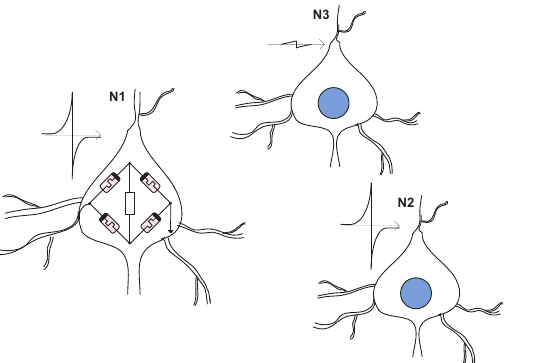
Fig. 9 : Three neurons, N 1 and N 2 are activated, N 3 is not activated ( e = 0 ).